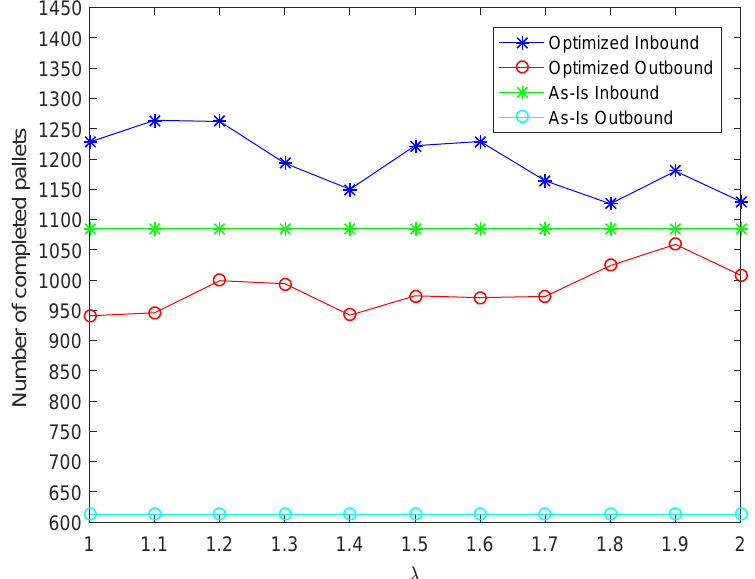
Figure 6. Numerical results for May 2019 data, given the numbers total inbound/outbound pallets of 1541/1981, and the numbers of completed pallets with the current worker allocation are